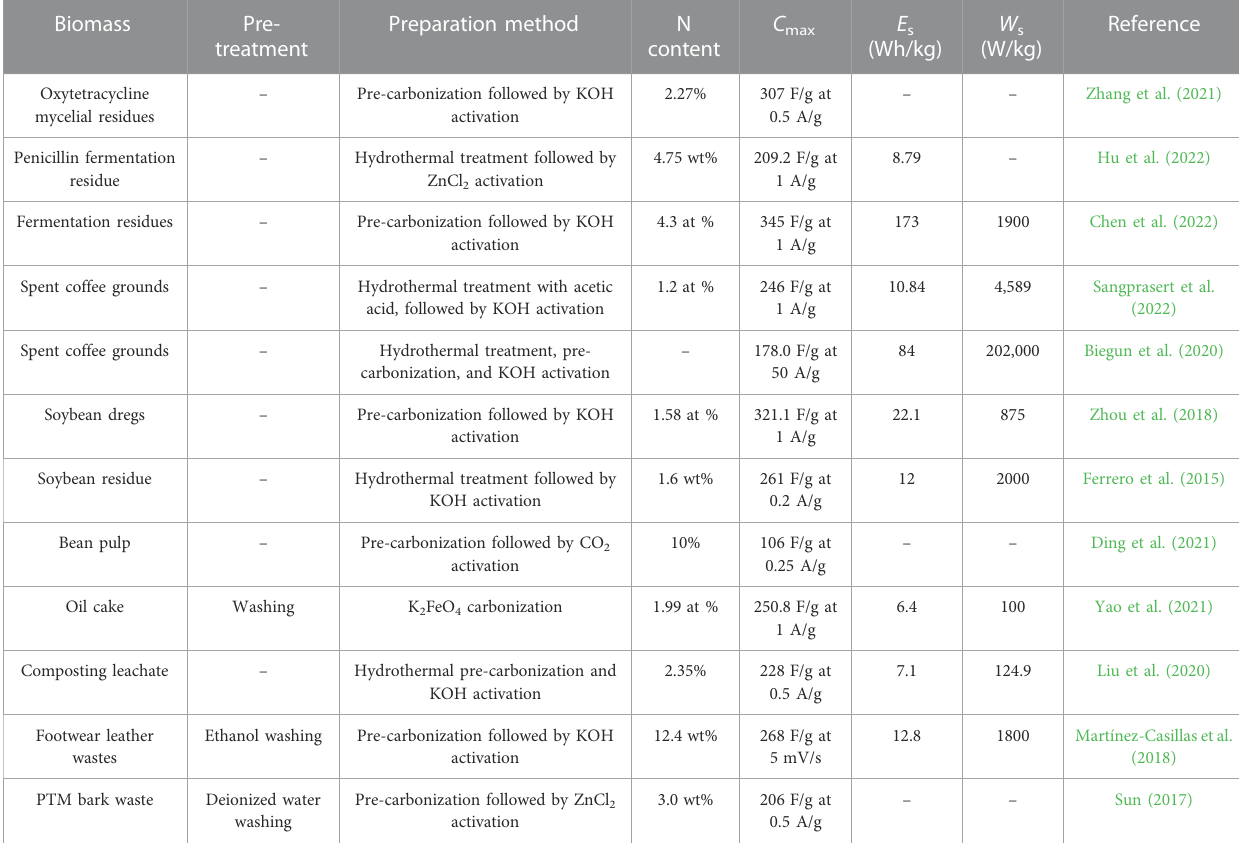
TABLE 5 Organic waste-based N self-doped biochar applications in